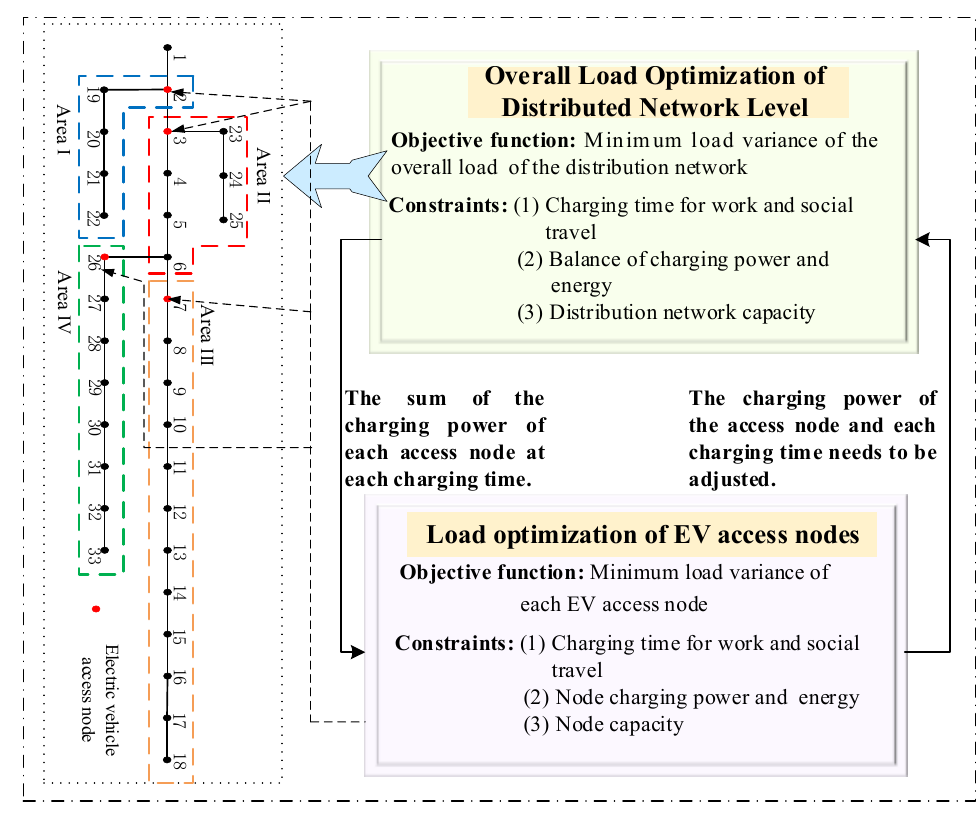
Figure 2. Hierarchical optimization model.